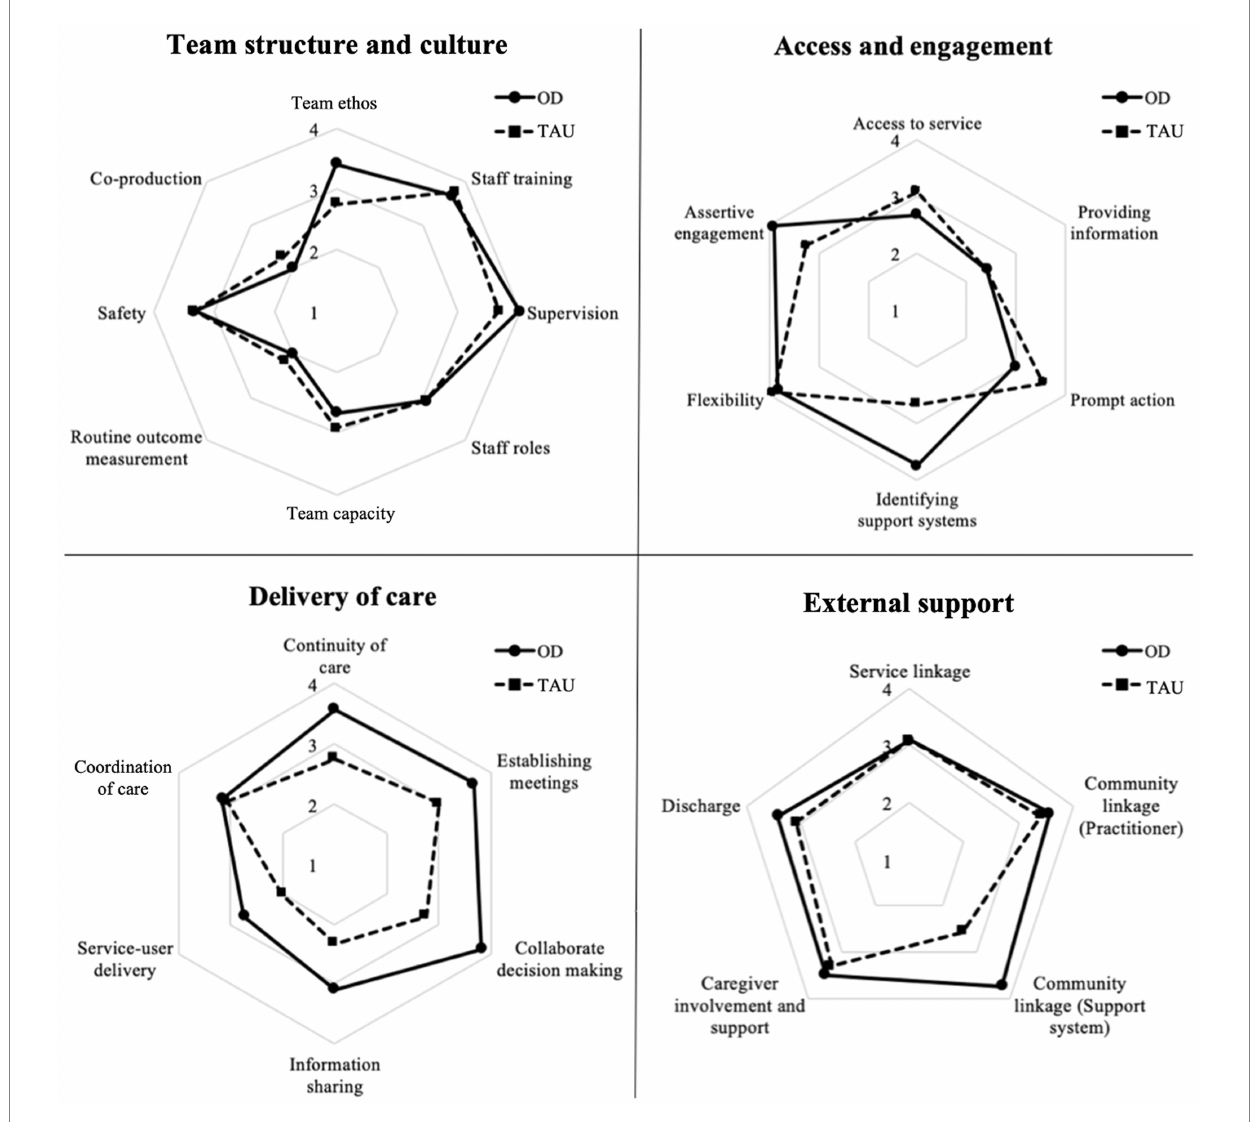
FIGURE 3 Comparison of mean COM-FIDE item scores between Open Dialogue (OD) and standard care (TAU).